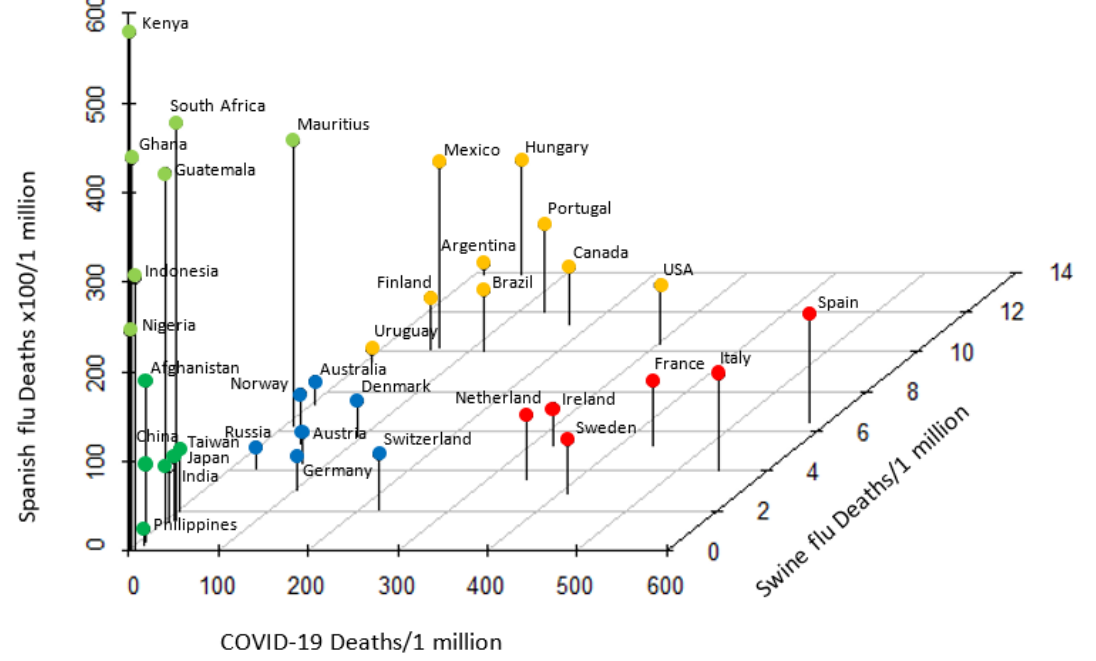
Figure 3. Pattern of mortality to Spanish flu, swine flu and COVID-19 pandemics. Countries with high, medium and low mortality from each pandemic were categorized into five distinct groups. With the exception of a few outliers, African, American, Asian and European countries were clustered, demonstrating a similar pattern of mortality to each pandemic.